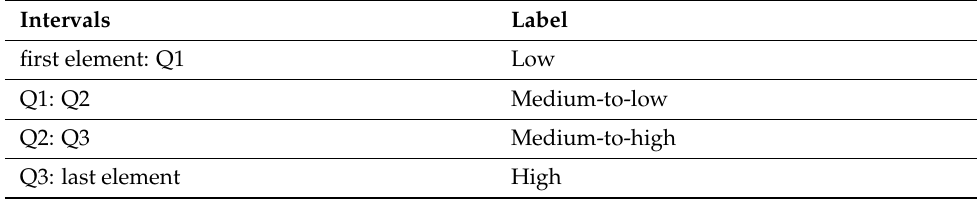
Table 1. Labels and intervals for cluster definition .